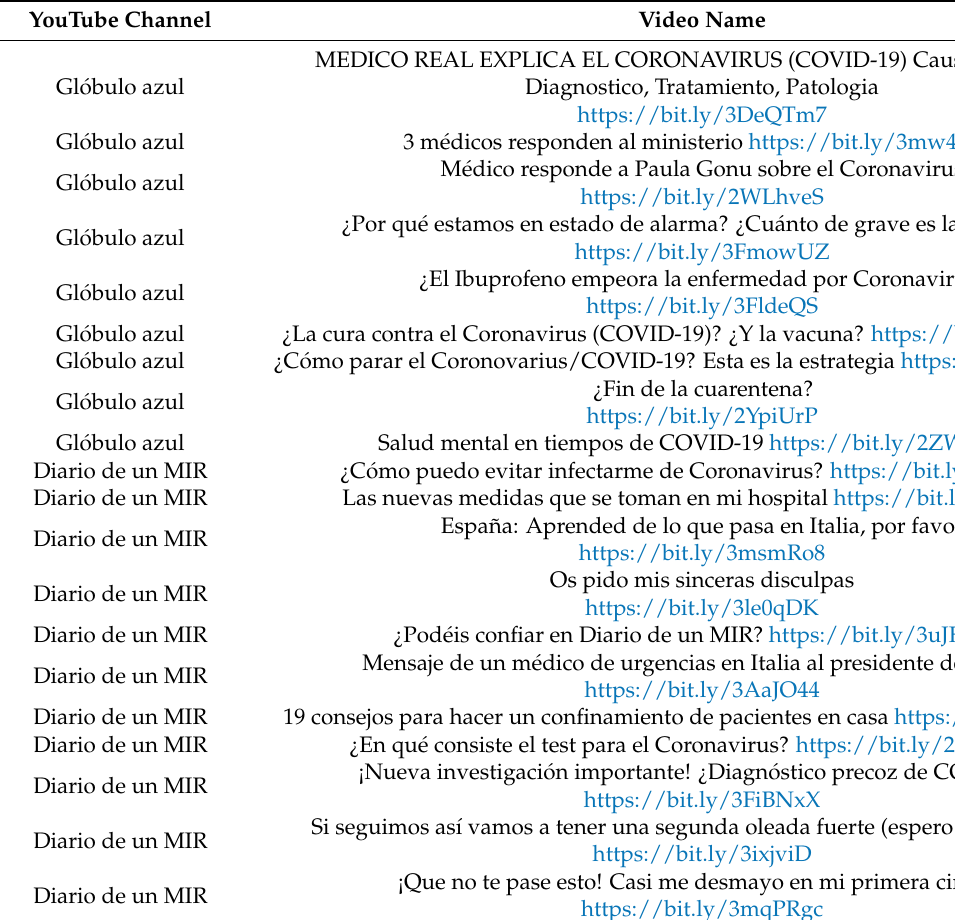
Table A1. Characteristics of the 54 videos included in the